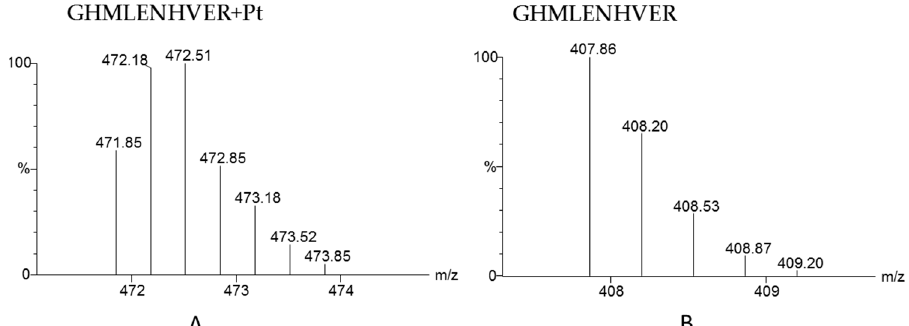
Figure 5. The theoretical MS spectra of platinated peptide GHMLENHVER ( A ) and the theoretical MS spectrum of peptide GHMLENHVER without Pt modification ( B ).